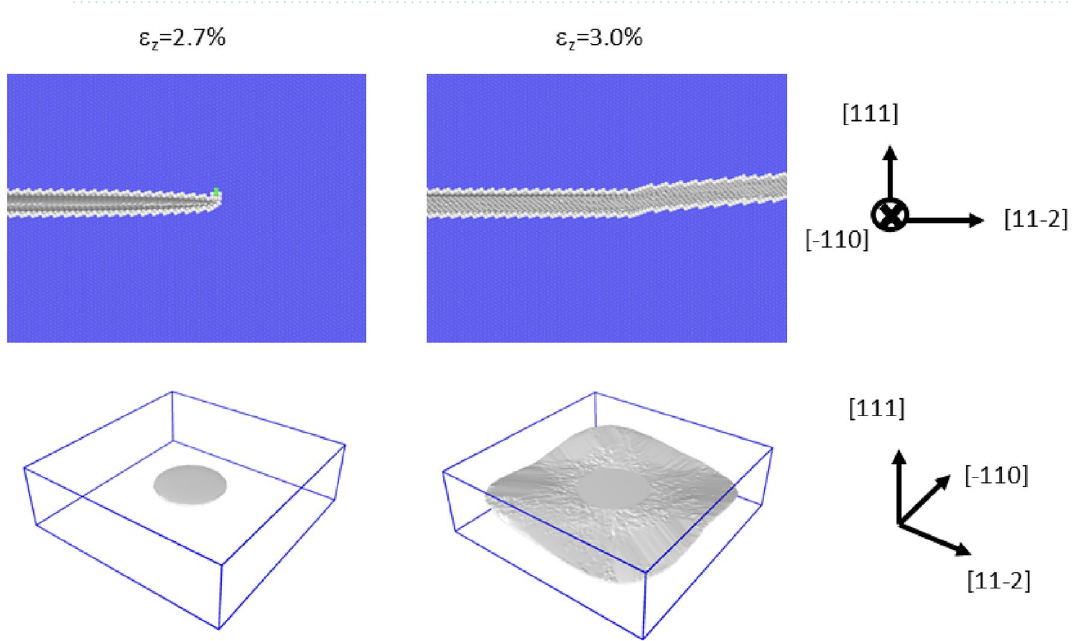
Figure 5. The initial condition of the {111} cleavage simulation and the snapshot after imposing 0.3% mode-I tensile strain. The upper diagrams show the cross sections in the vicinity of the crack front. The common neighbor analysis is used for determining the atomic color. The bottom diagrams show the cracked surfaces in